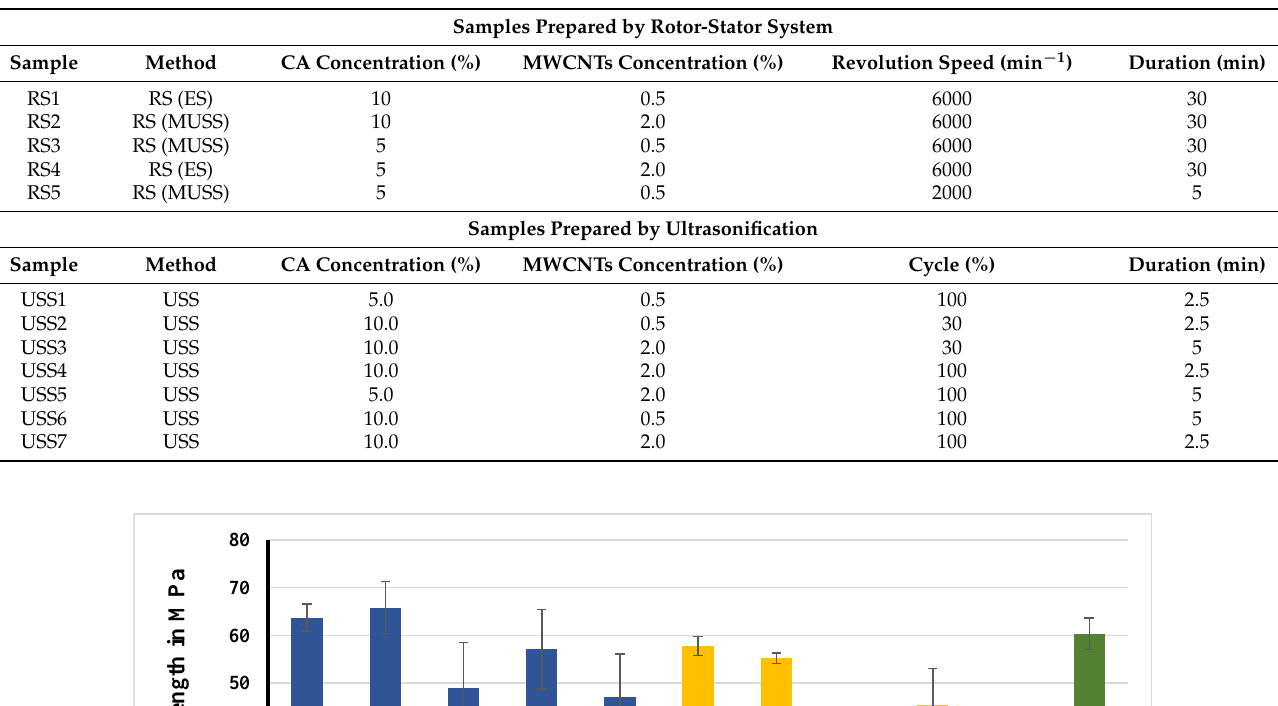
Table 4. Parameters used for preparation of samples for mechanical analysis.